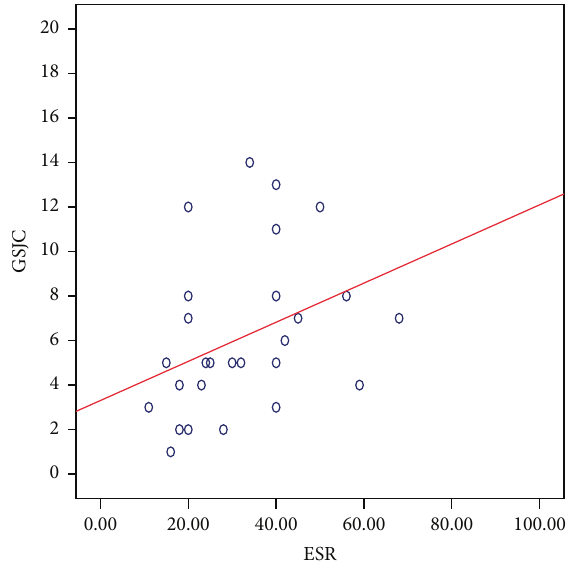
Figure 10: Relation between GSJC (taken from 28 MCP, PIP, and DIP joints) and ESR in 30 patients with PsA. Spearman’s 𝜌 : 0.478; 𝑃 : 0.008 suggesting a significant